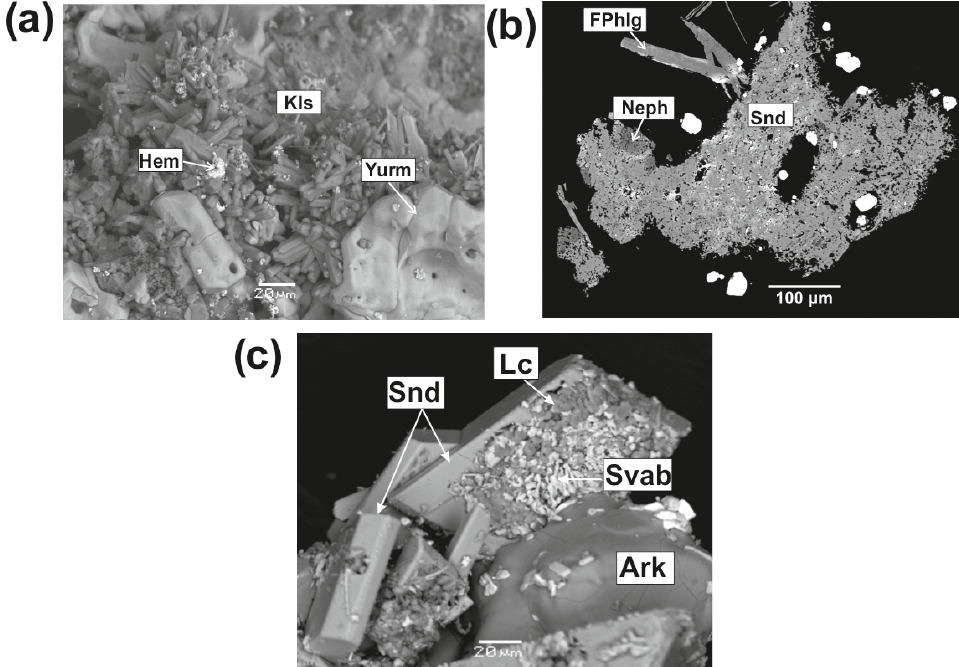
Figure 6. Kalsilite and nepheline from the Arsenatnaya fumarole: hexagonal prismatic crystals of kalsilite (Kls) with hematite (Hem) and yurmarinite (Yurm) (a) ; nepheline (Neph) in crust consisting of sanidine (Snd) with fluorophlogopite (FPhlg), leucite (Lc) with sanidine (Snd), hematite (Hem), svabite (Svab) and arkanite (Ark) (c) . BSE images.